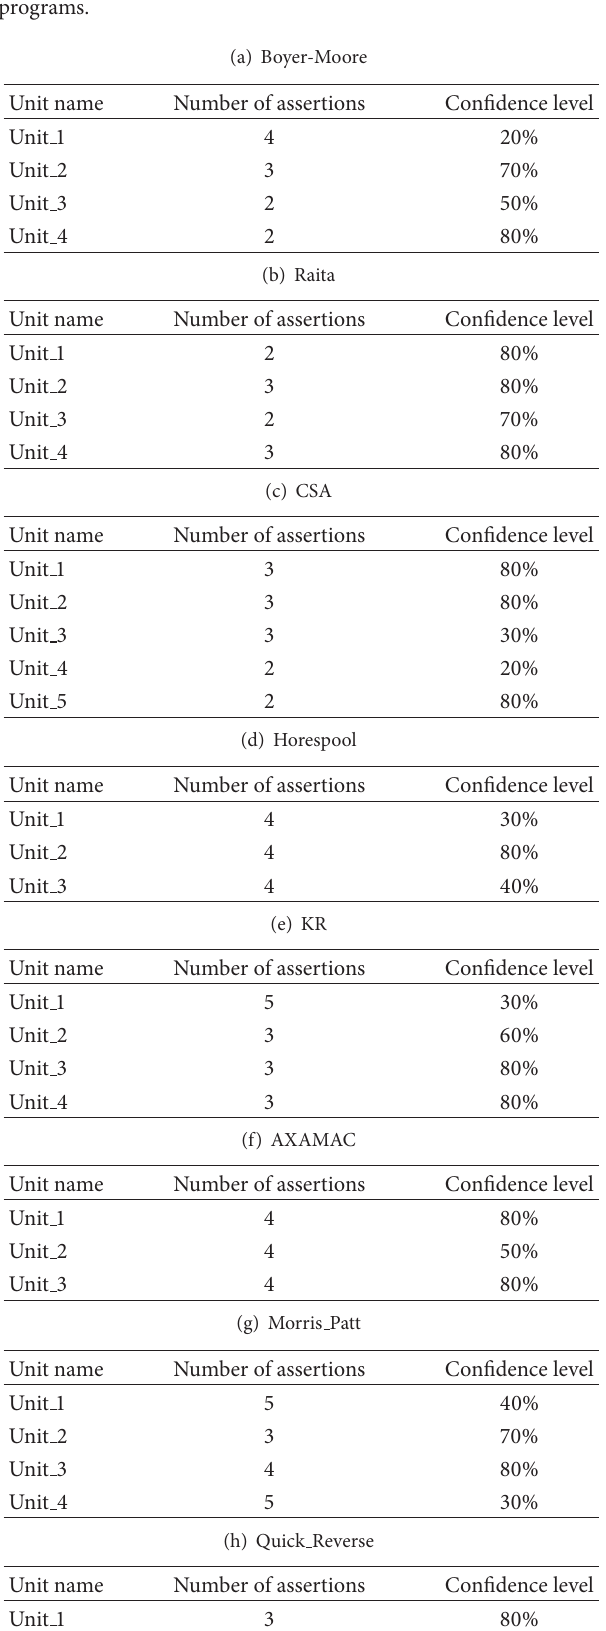
Table 3: De5elopers’ confidence level on the correctness of their